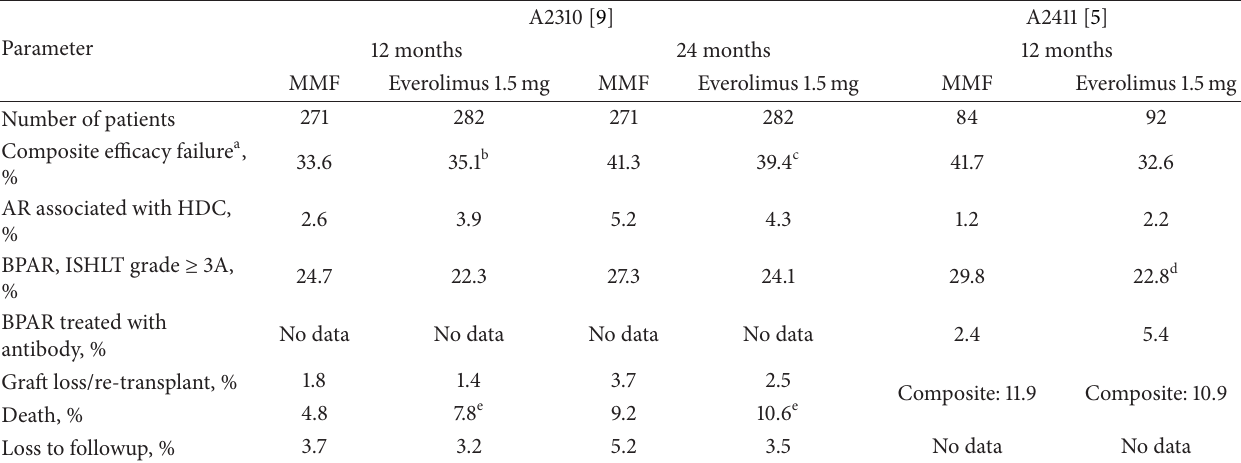
Table 2: Efficacy endpoints in randomized trials of everolimus with reduced-exposure cyclosporine versus MMF with standard-exposure